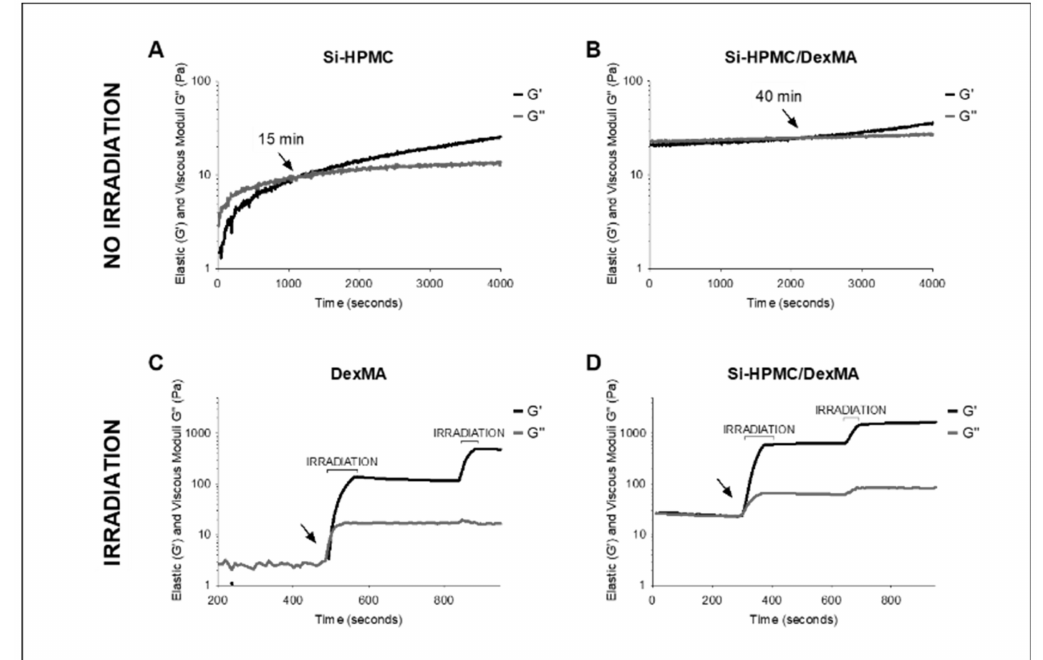
Figure 2. Elastic (G (cid:48) ) and viscous moduli (G (cid:48)(cid:48) ) as a function of time (seconds) of ( A ) Si-HPMC and ( B ) Si-HPMC/DexMA without irradiation, ( C ) DexMA, and ( D ) Si-HPMC/DexMA under a first irradiation of 80 s and a second irradiation of 40 s. The gel point is indicated by an arrow. The polymer concentrations were Si-HPMC at 1.14% ( w / v ), Si-HPMC/DexMA at 1.14% ( w / v )/17.15% ( w / v ), and DexMA at 17.15% ( w / v ). The data were recorded at 6.8 rad/s frequency, 1% strain, and room temperature, and the lamp used for irradiation had λ = 450 nm. Si-HPMC: silanized hydrox- ypropyl methylcellulose, DexMA: dextran methacrylate, Si-HPMC/DexMA: silanized hydroxypropyl methylcellulose/dextran methacrylate.